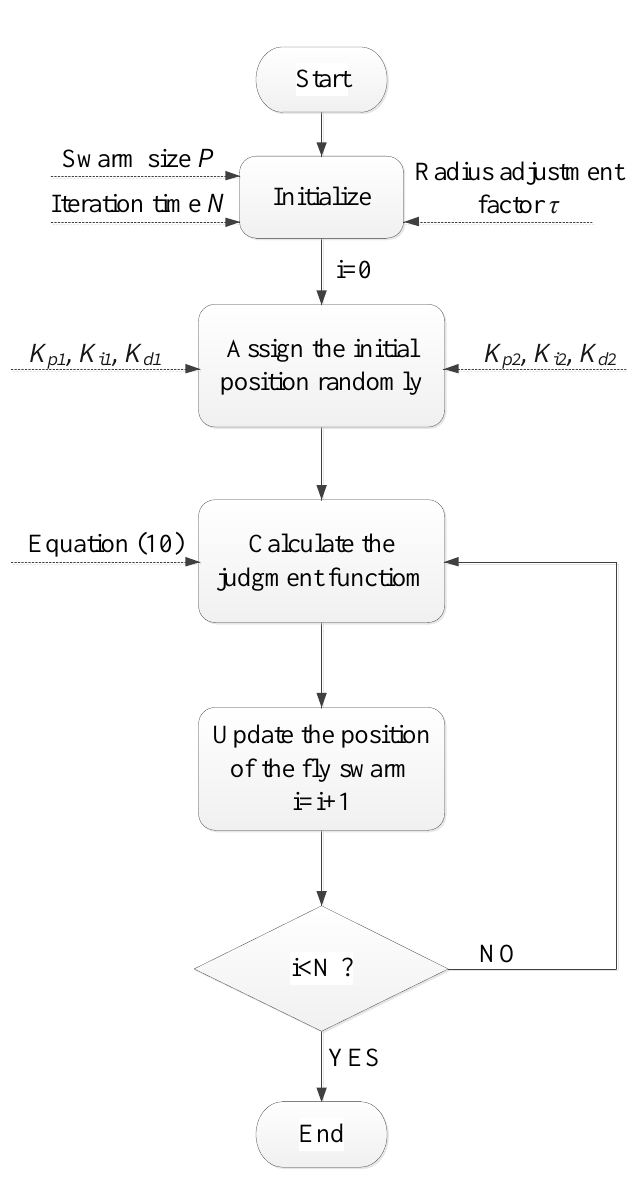
Figure 7. The block diagram of the FOA scheme.